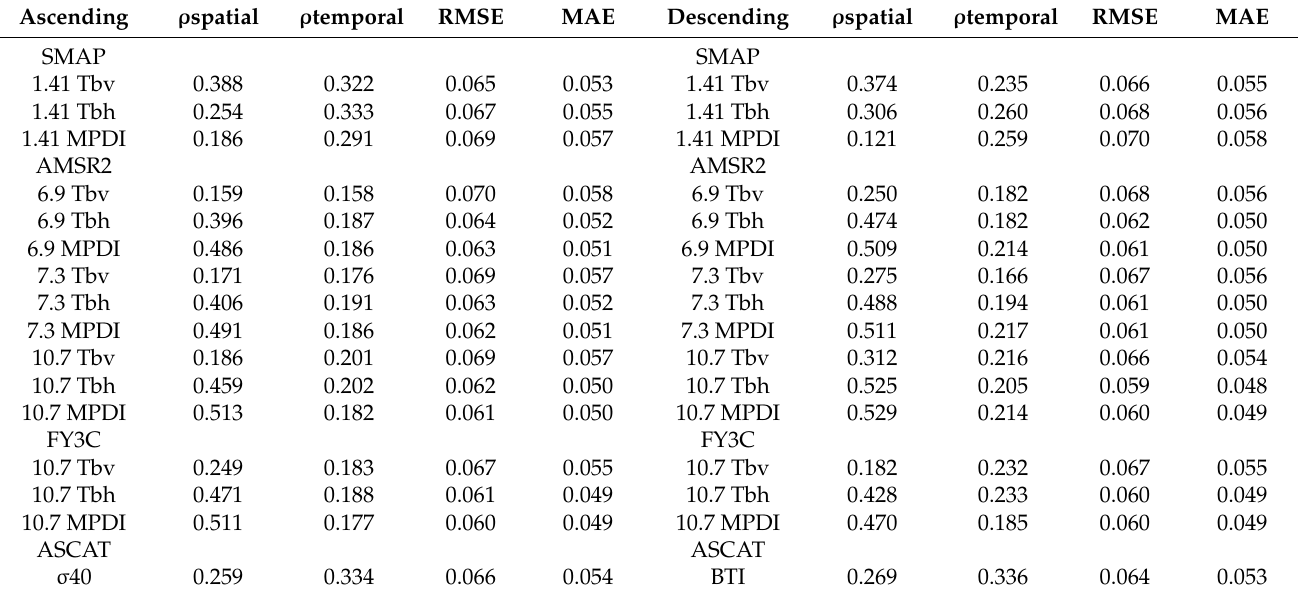
Table 3. Average quality index for soil moisture calculated by comparing a single microwave input dataset with data from CLDAS.